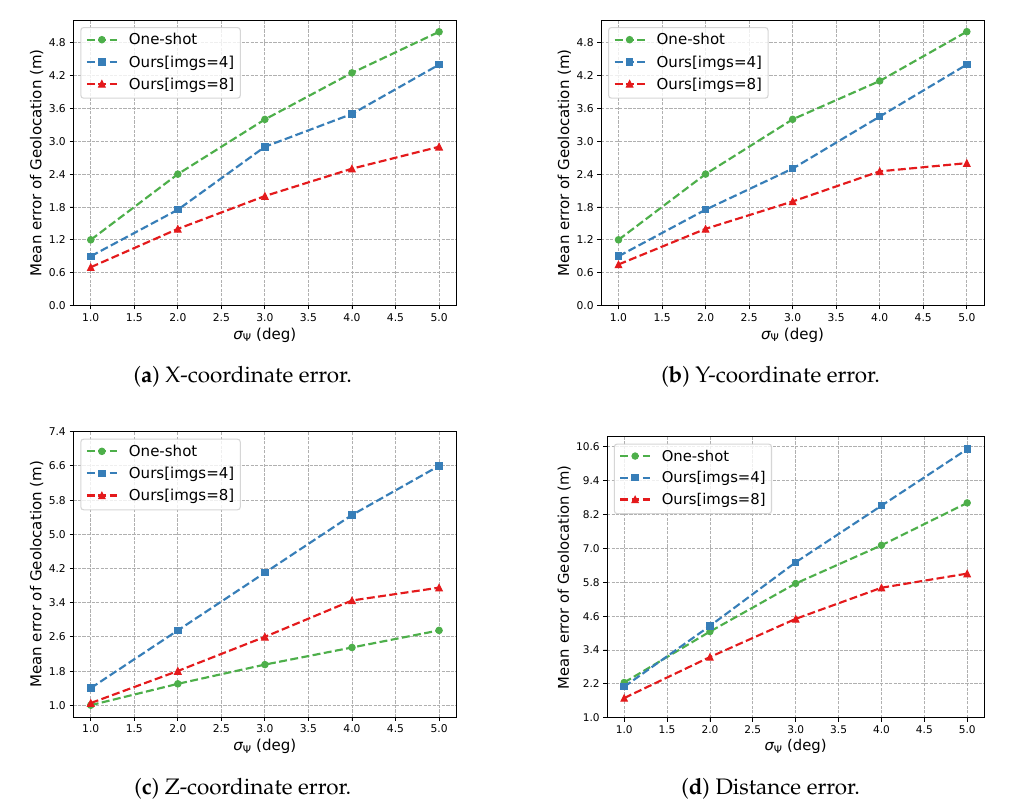
Figure 9. Geolocation errors under different measurement errors of